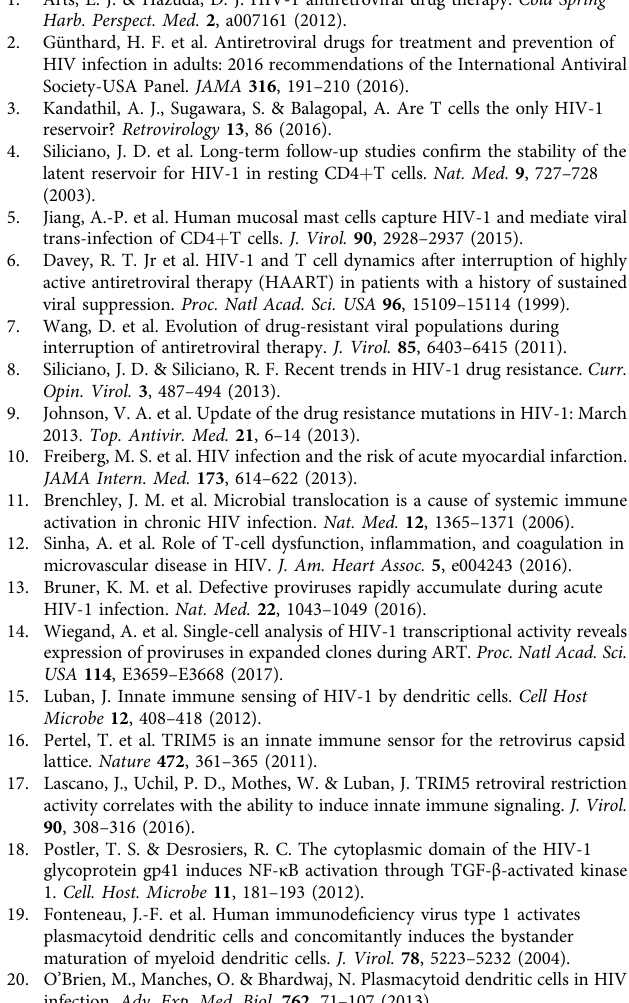
Fig. 4 Innate immune activation in macrophages and CD4 + T cells. a Macrophages and CD4 + T cells were transduced with HIV-1-GFP and assayed 3